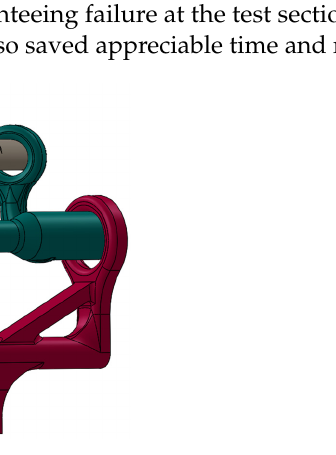
Figure 9. Three-part design: upper handle, test tube, and lower handle.